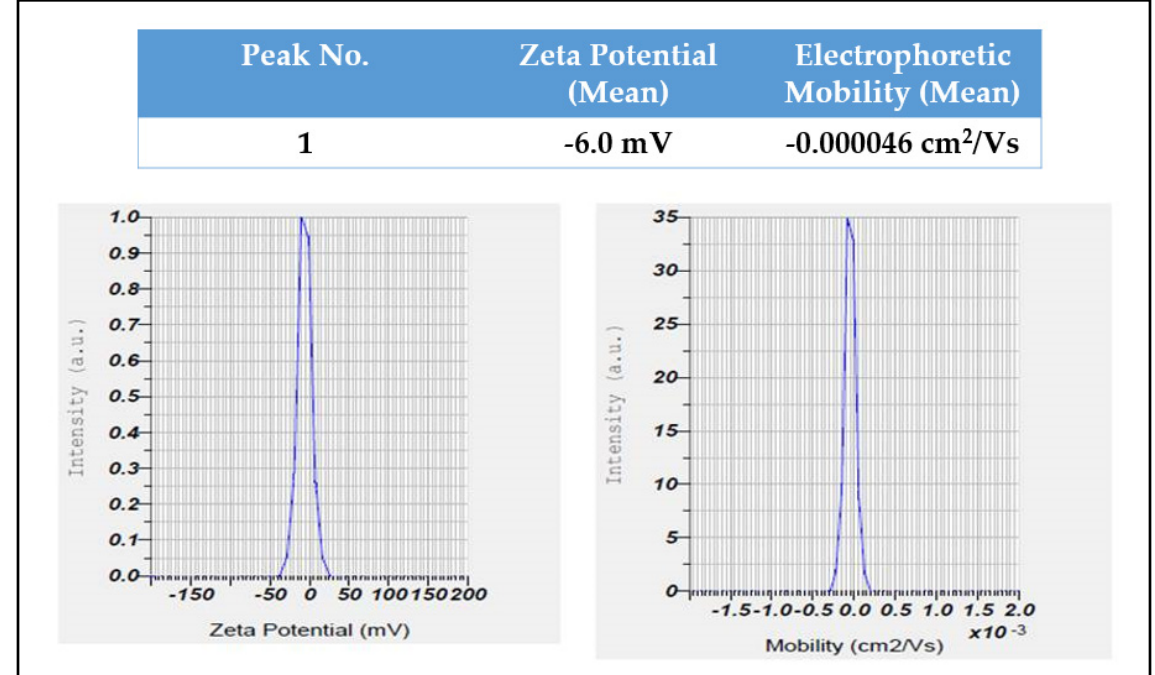
Figure 7. Zeta potential distribution of R. apiculata AgNPs.